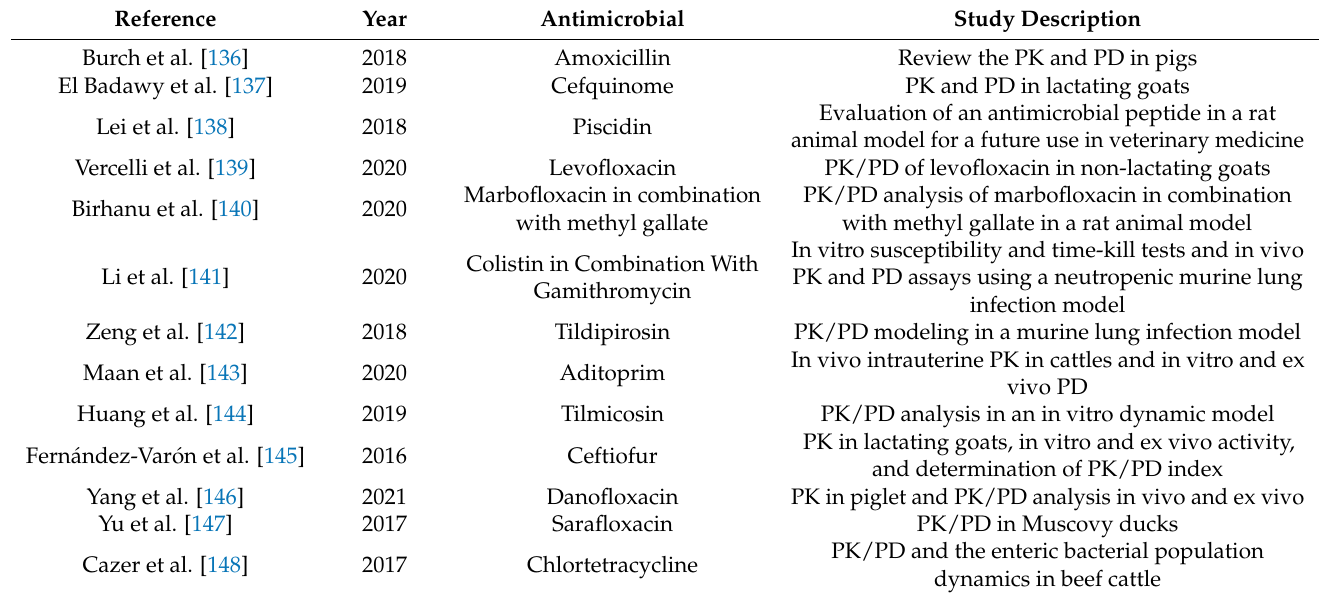
Table 4. Published articles about PK/PD modeling in veterinary